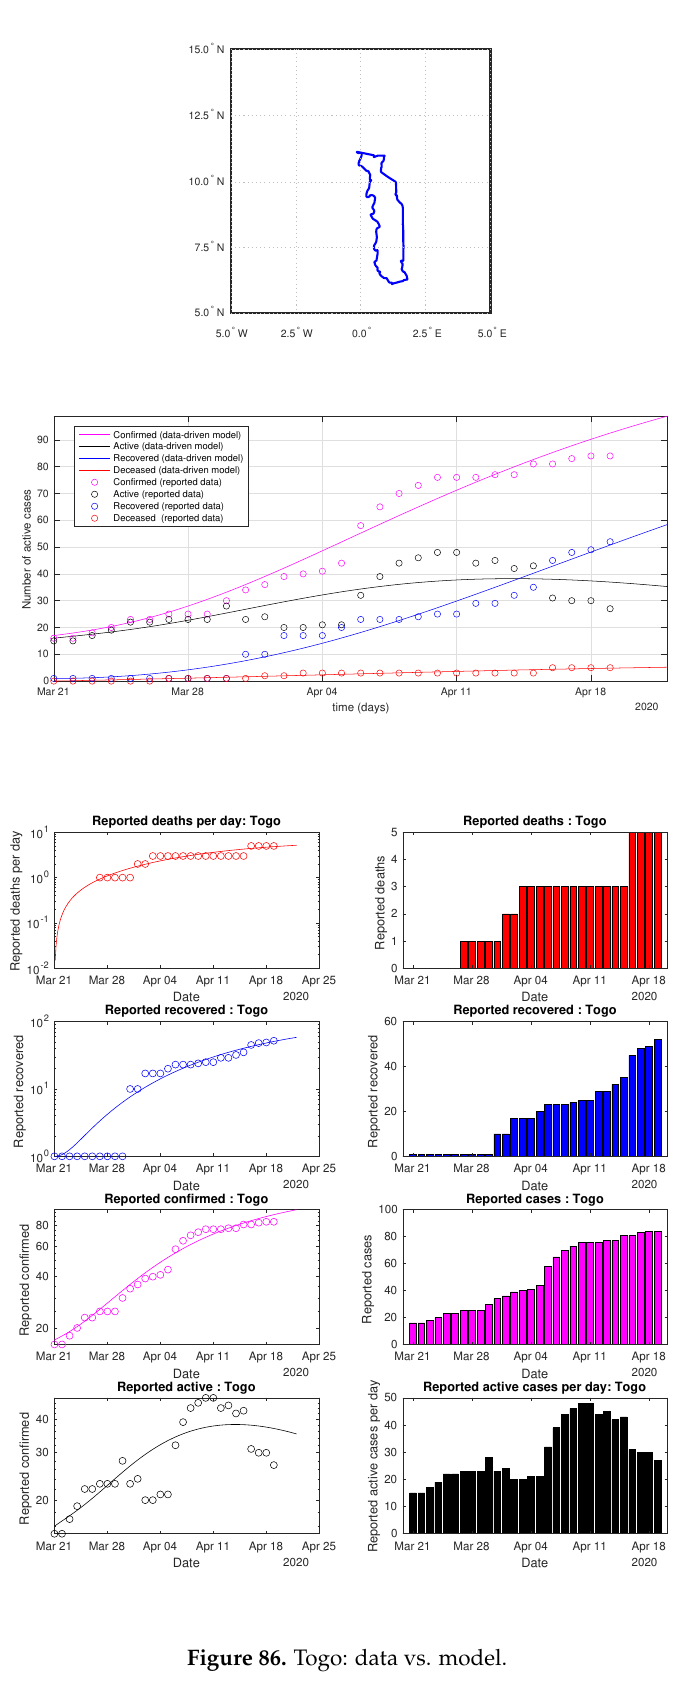
Figure 86. Togo: data vs.